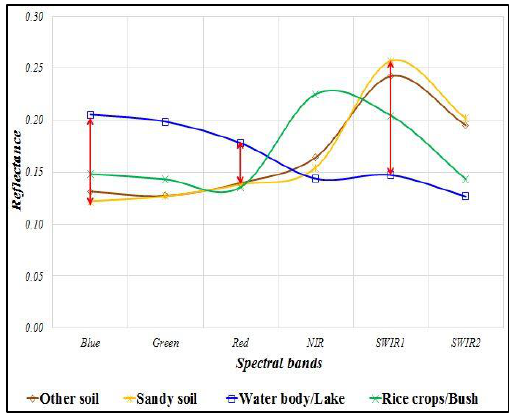
Figure 5. Reflectance of the four types of soils dryness